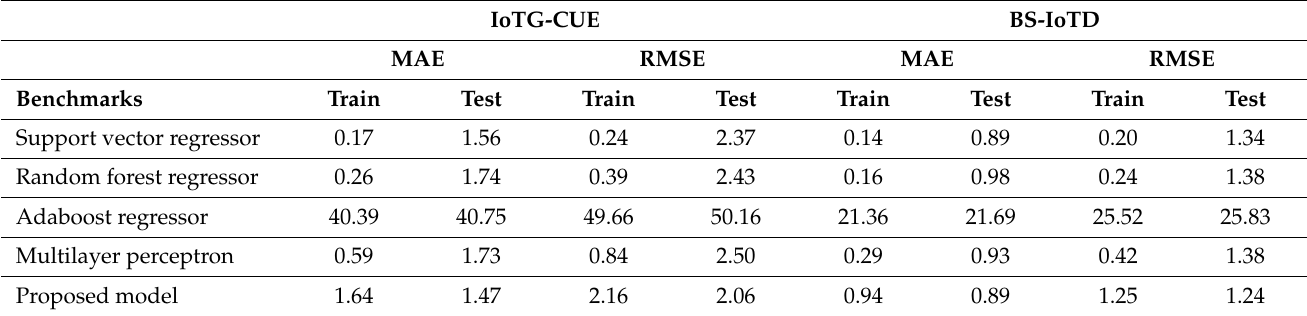
Table 7. Average result of the 10-fold cross validation method comparing the proposed downlink model versus various benchmarks including the support vector regressor, random forest regressor, Adaboost regressor, and multilayer perceptron.